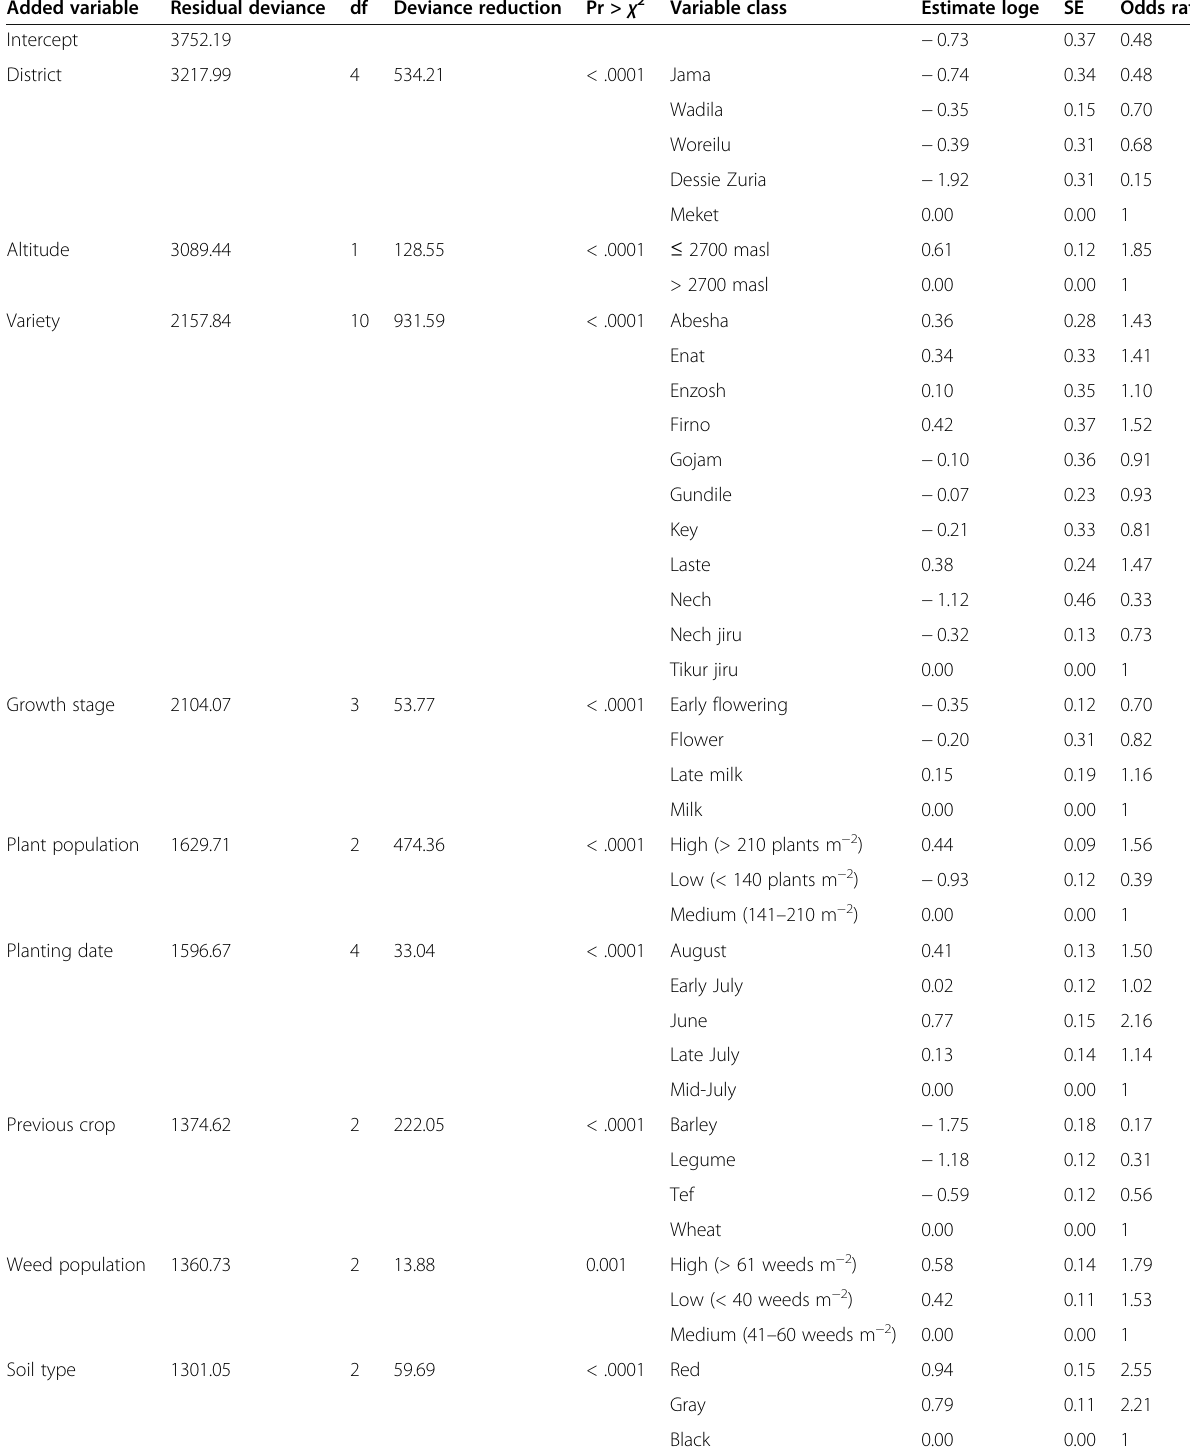
Table 4 Analysis of deviance, natural logarithms of odds ratio, and standard error of added variables in a reduced model analyzing septoria tritici blotch